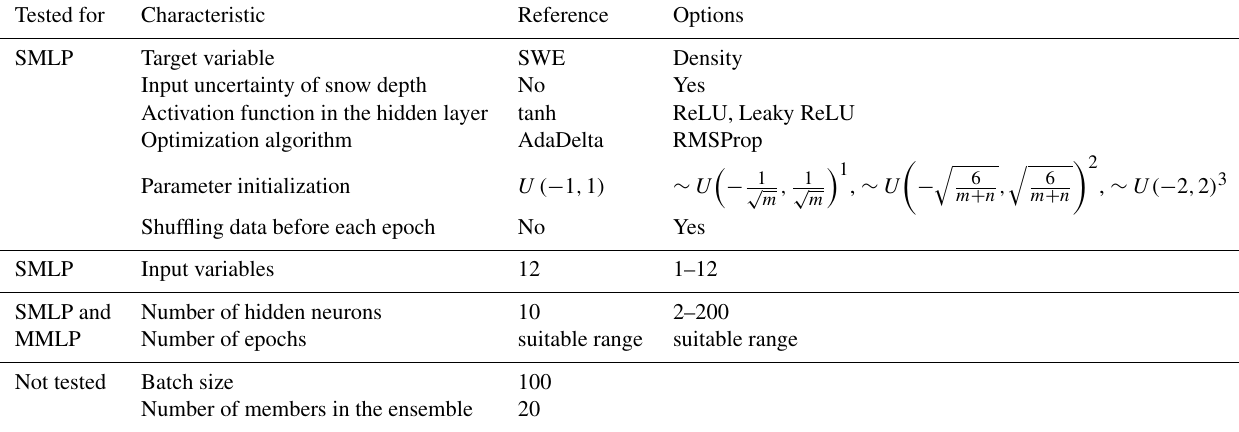
Table 2. A summary of the reference MLP ensemble setup and the tests performed to obtain the final MLP architecture. SMLP refers to the single MLP ensemble model and MMLP to multiple MLP ensemble model; note that we track the performance of the model on the validation data set over a range of epochs until evaluation metrics show worse results to determine the correct training time. Tested